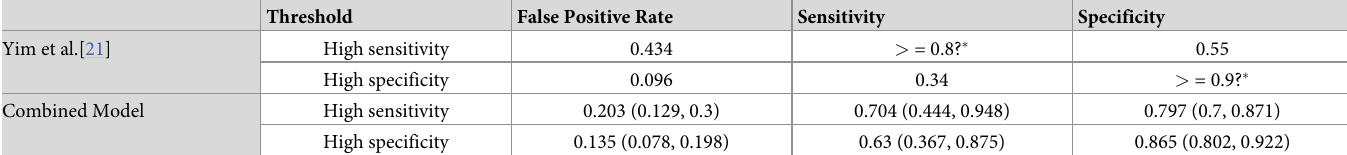
Table 4. Performance metric comparison of our combined model and reported performance metrics of the model proposed by [21] using the same selection crite- ria. � Question marks indicate values not clearly reported.